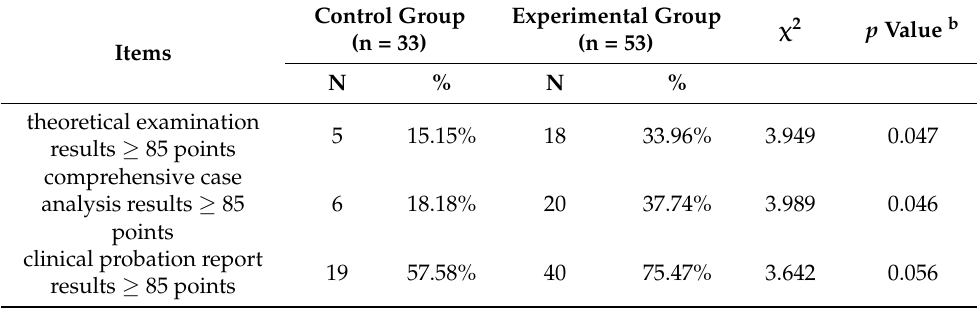
Table 4. Comparison of students’ achievement assessments between two